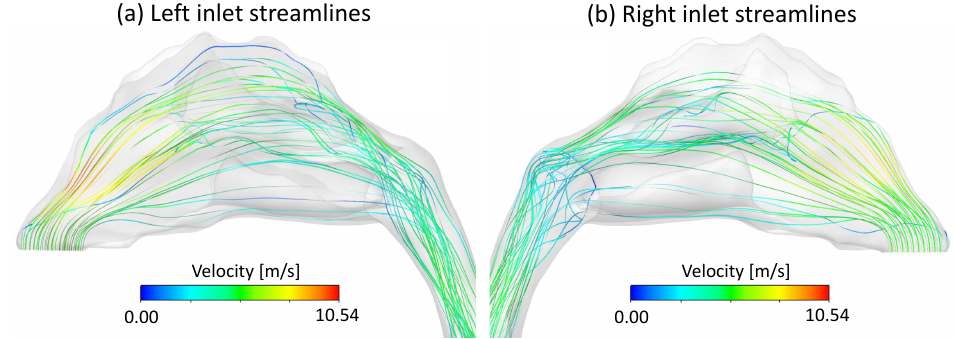
Figure 3. Streamlines of airflow velocity: ( a ) Left inlet streamlines, and ( b ) Right inlet